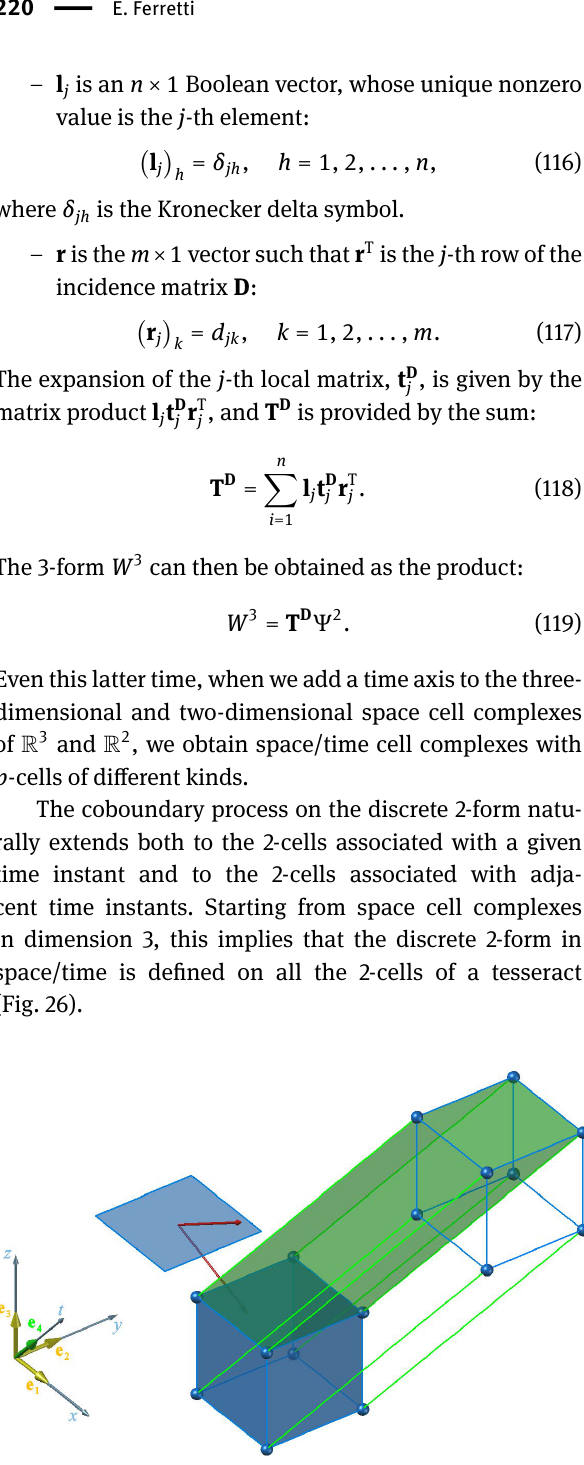
Figure 26: The coboundary process on a discrete 2-form defined for one face t = t 1 of a tesseract.